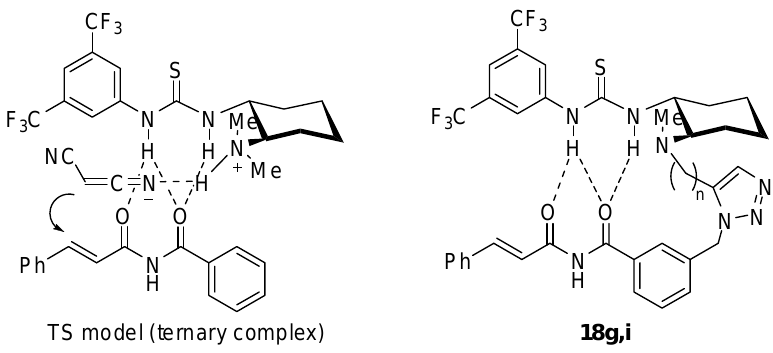
Figure 3. A transition state model for a Michael addition to imide with bifunctional thiourea 1 (left), and its mimetic hybrid molecules 18g,i